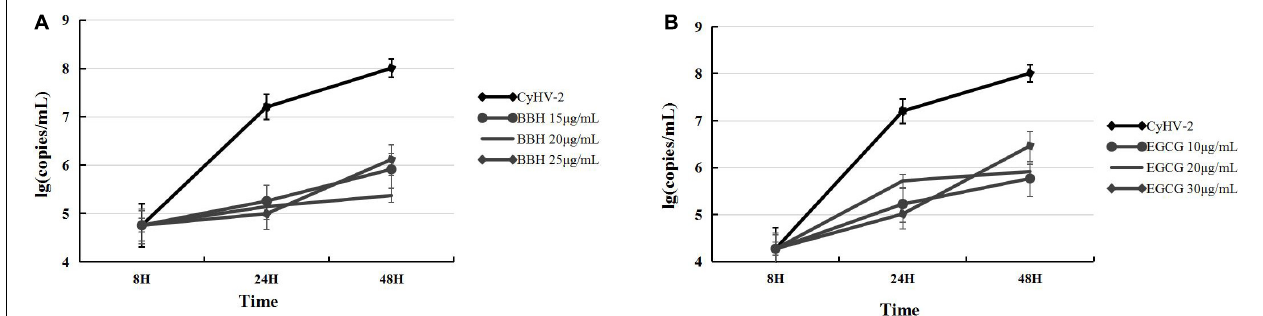
FIGURE 7 | BBH and EGCG inhibited the production of progeny virus in RyuF-2 cells infected with CyHV-2. RyuF-2 cells were treated with 15, 20, and 25 µ g/ml BBH (A) or 10, 20, and 30 µ g/ml EGCG (B) and infected with CyHV-2 at a MOI = 1. At 8, 24, and 48 h p.i., supernatants of infected cells were harvested for viral